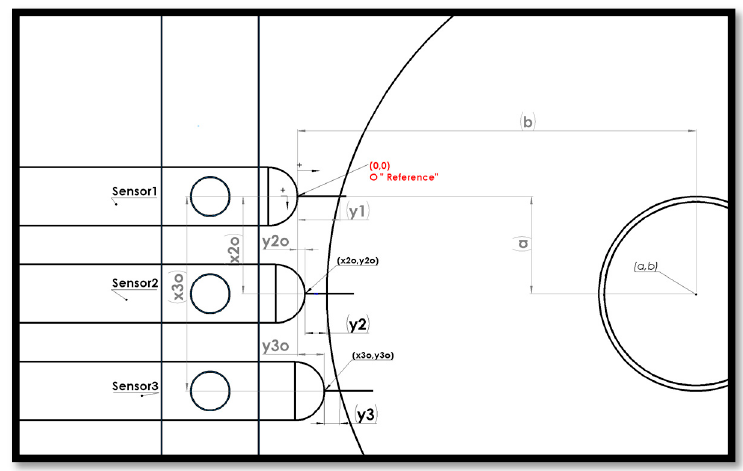
Figure 6. Validation of the TPFK/TPIK algorithms by CAD simulation: ( a ) calibration master assembly. ( b ) Inspected part assembly.